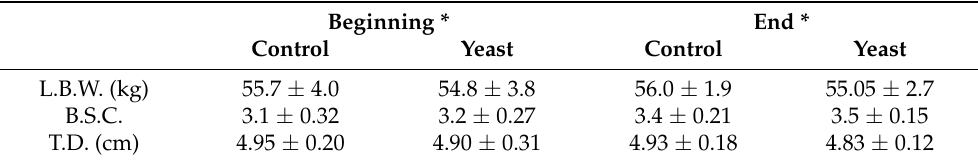
Table 2. Live weight, body score condition and testicular diameter of control and yeast-treated rams Table 3. Sperm quality traits of control and yeast-treated Queue Fine de l’Ouest rams (means ± (means ± S.E.M.). S.E.M.).